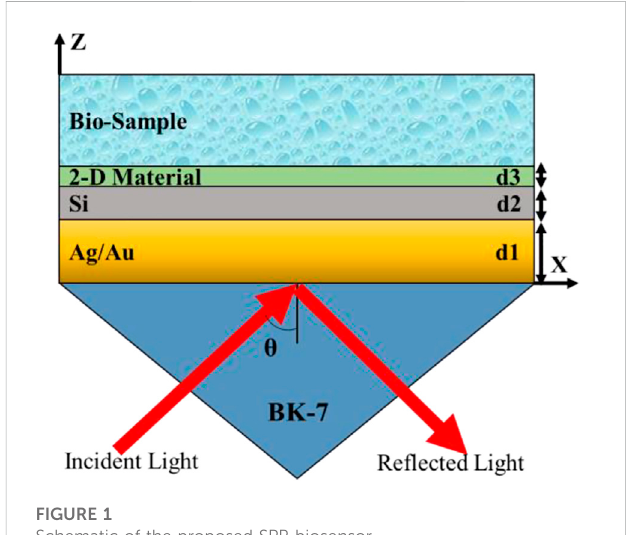
FIGURE 1 Schematic of the proposed SPR